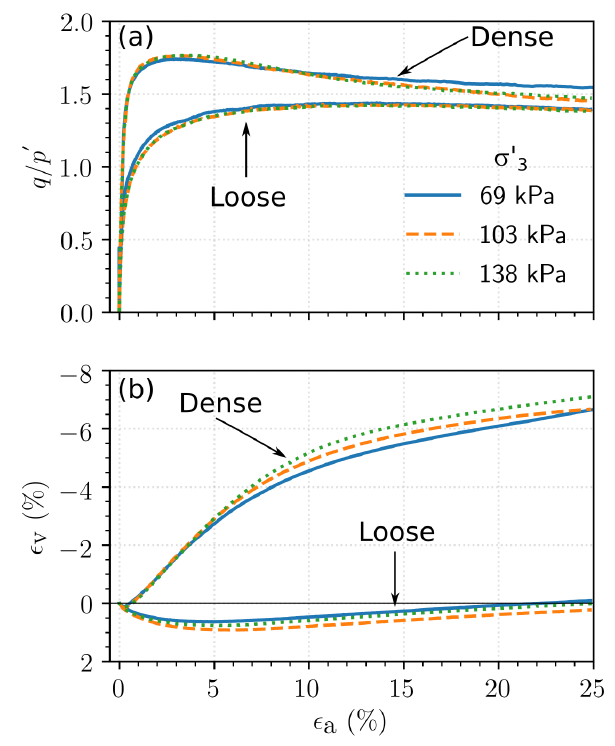
Figure 12. Response of Q-Rok to drained triaxial compression: ( a ) Stress–strain relationship, ( b ) Volumetric